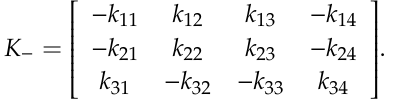
speed values (vectors rotating counterclockwise) and ( b ) negative speed values (vectors rotating clockwise) with